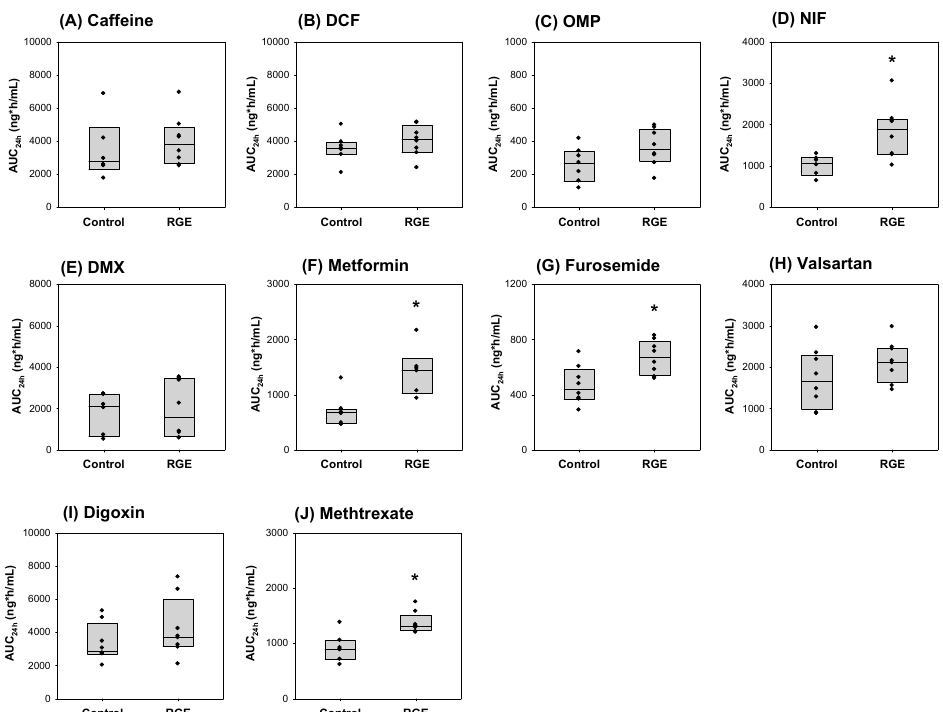
Figure 7. The comparison of AUC values of ( A ) caffeine, ( B ) diclofenac (DCF), ( C ) omeprazole (OMP), ( D ) nifedipine (NIF), ( E ) dextromethorphan (DMX), ( F ) metformin, ( G ) furosemide, ( H ) valsartan, ( I ) digoxin, and ( J ) methotrexate between the control and RGE treatment groups. * p < 0.05 is considered statistically significant compared with the control group by the Mann-Whitney U test. The data are presented as the means ± SD ( n = 7).